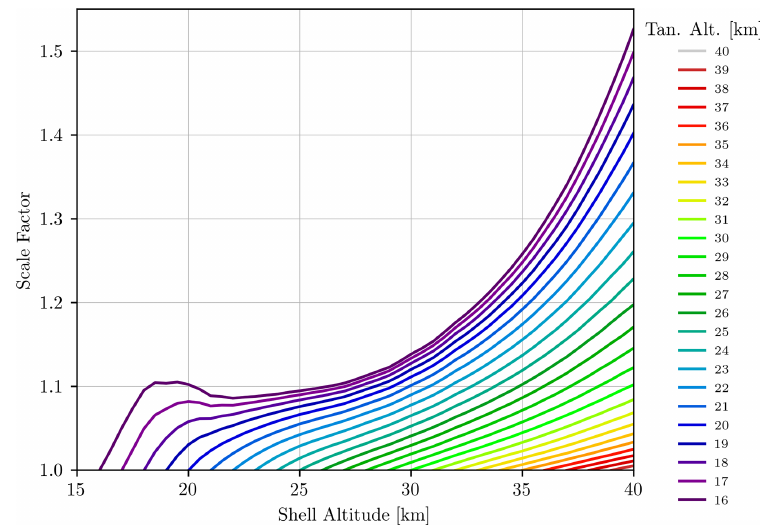
Figure 5. Scale factors along each line of sight for a sunset occultation at the Equator in March, simulated with PRATMO.